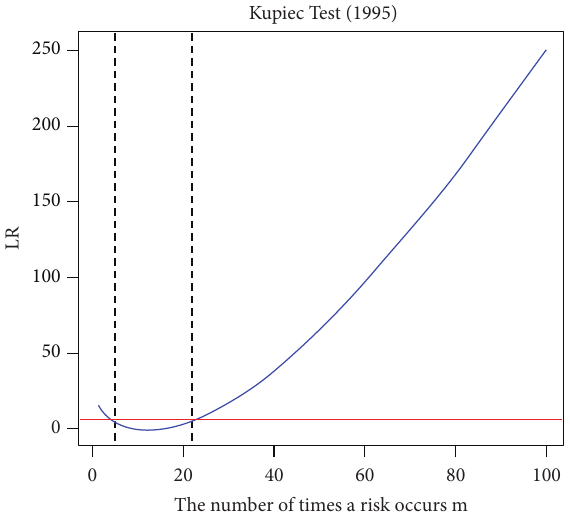
Figure 5: Interval chart of risk days at 99% confidence level.